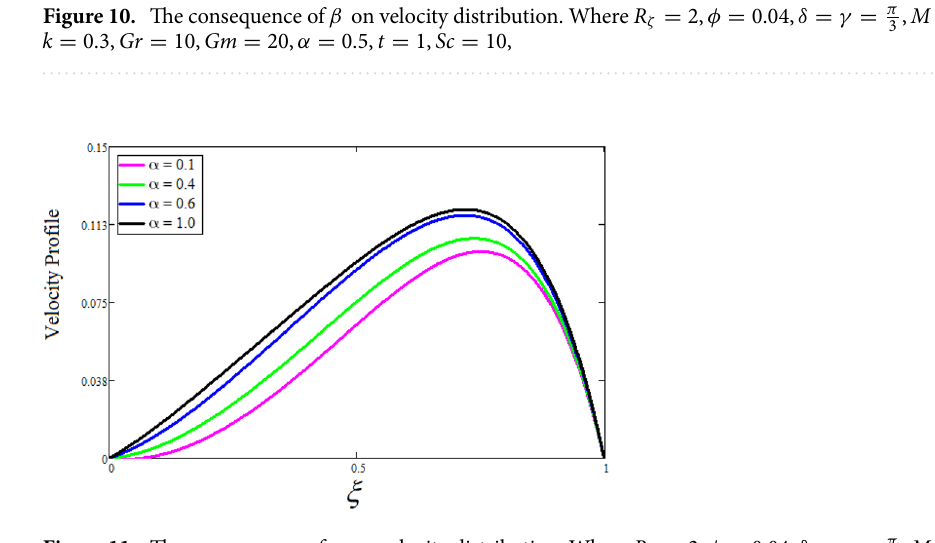
Figure 11. The consequence of α on velocity distribution. Where R ζ = 2, φ = 0.04, δ = γ = π 3 , M = 5, k = 0.3, Gr = 10, Gm = 20, β = 0.2, t = 1, Sc =